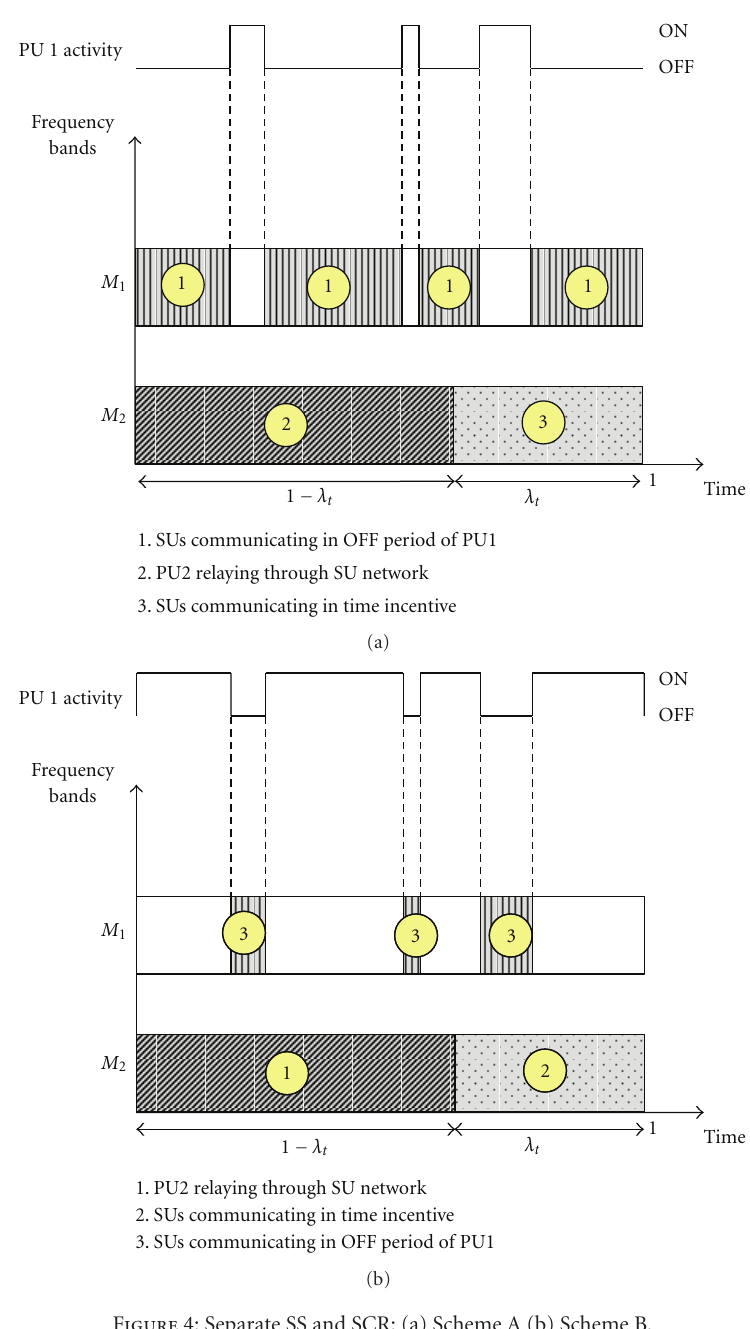
Figure 4: Separate SS and SCR: (a) Scheme A (b) Scheme